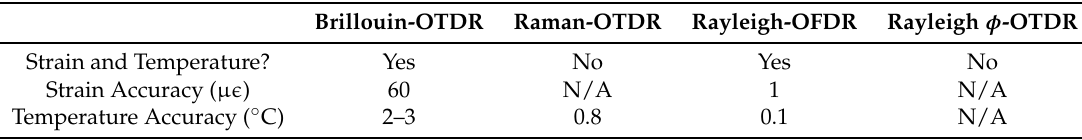
Table 2. Strain and Temperature Accuracy. (Adapted from